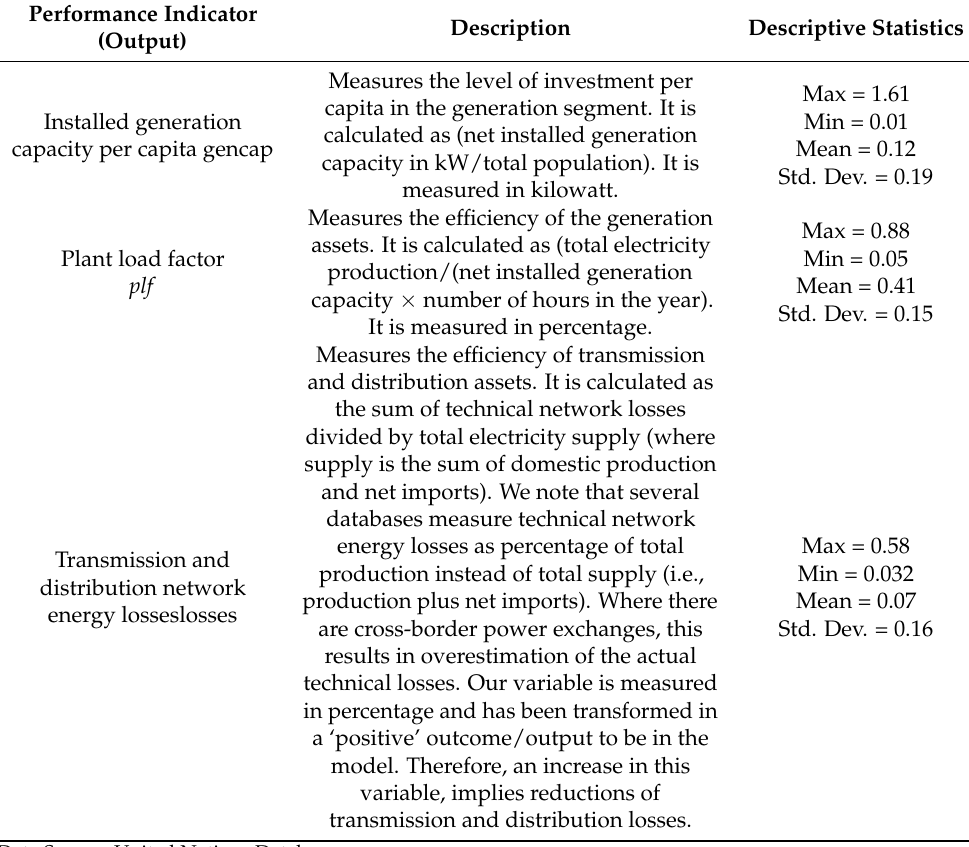
Table 2. Description of performance indicators